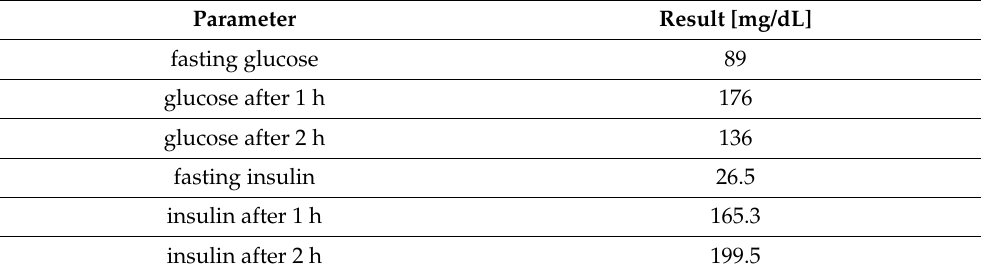
Table 4. Comparing patient X results with reference values.